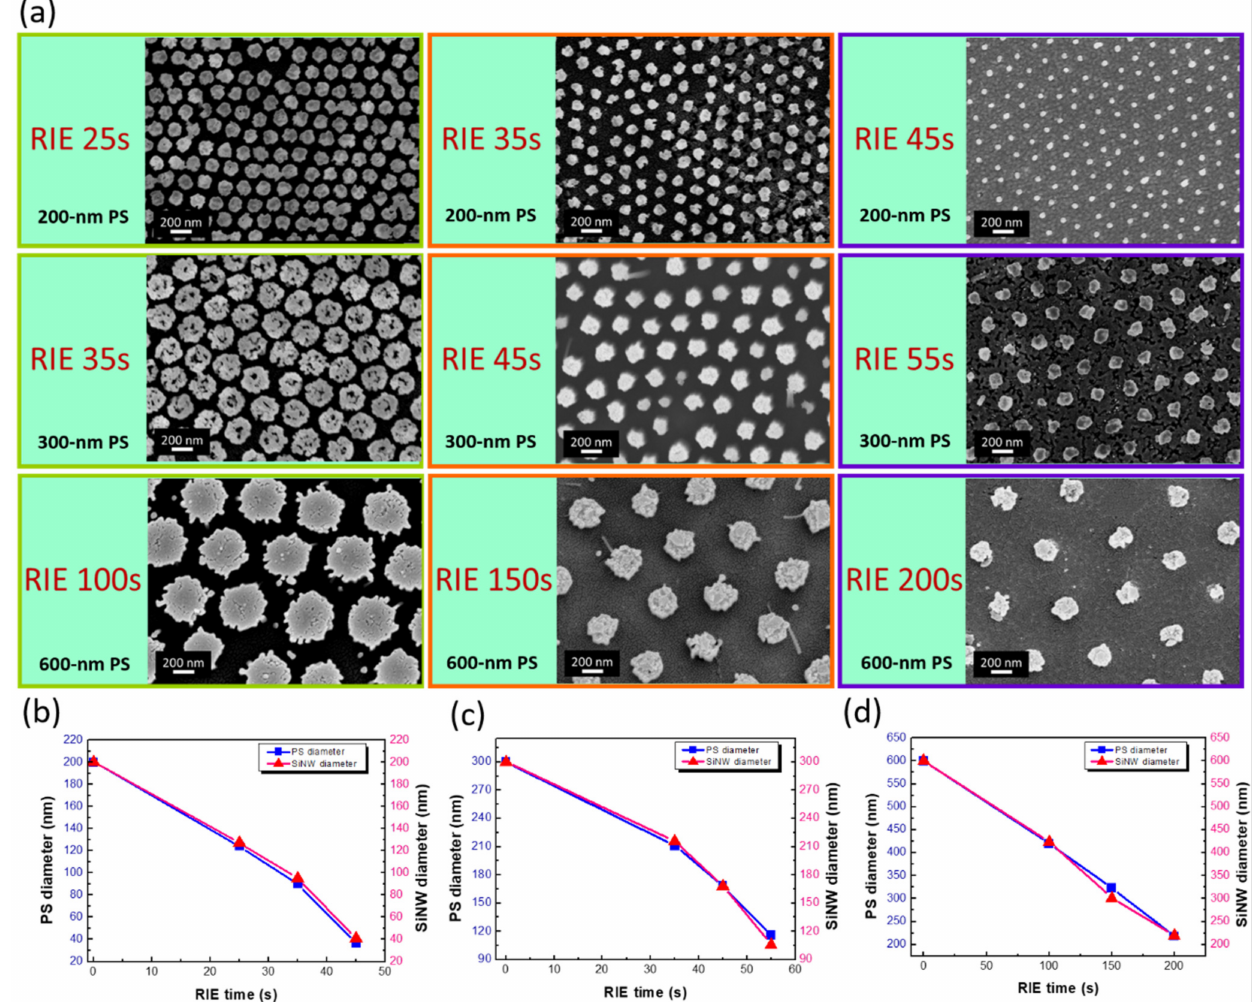
Figure 4. ( a ) Top-view SEM images of SiNW arrays formed with NSL patterning and MaCE process. Correlation of PS diameter with NW size under various RIE durations using ( b ) 200 nm PSs, ( c ) 300 nm PSs, and ( d ) 600 nm